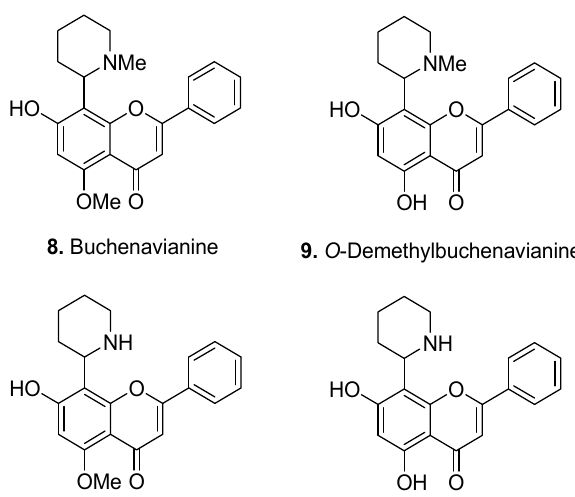
Figure 4. Buchenavianine ( 8 ) and Buchenavianine derivatives ( 9–11